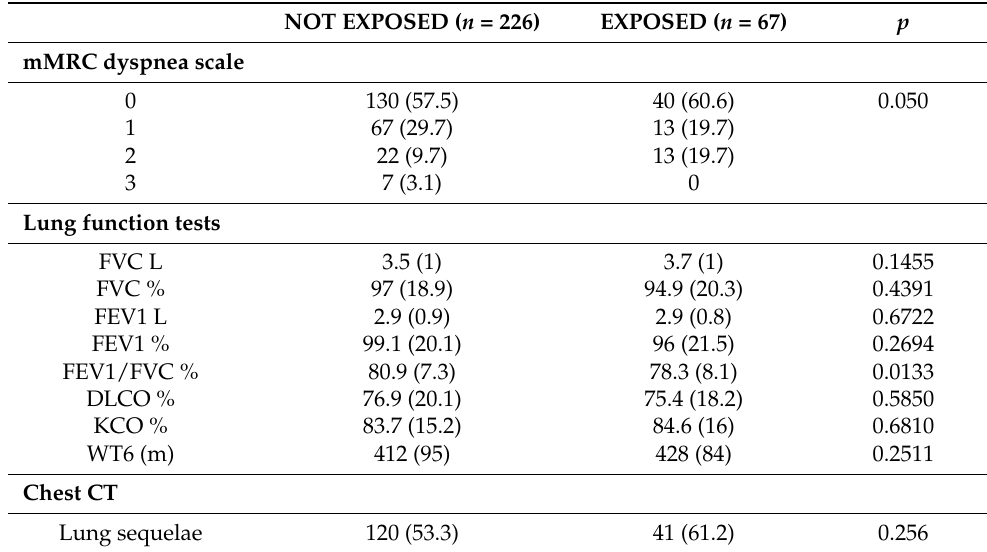
Table 3. mMRC dyspnea scale, lung function, and chest CT after hospitalization a . NOT EXPOSED ( n =